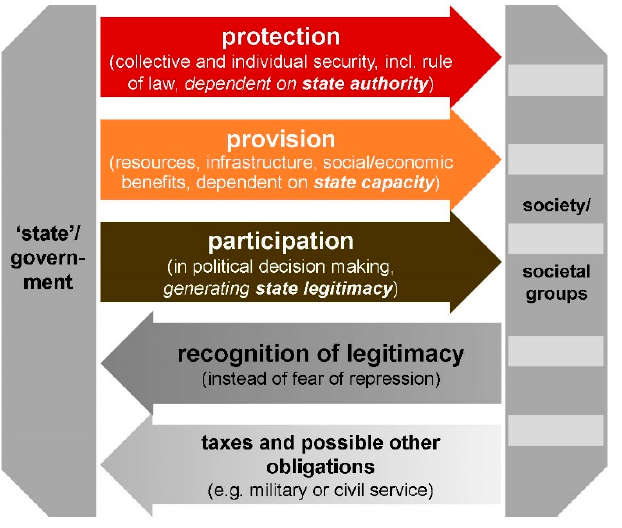
Figure 1. Deliverables in a social contract. Source: Loewe et al. (2019). Available online: https://www.die-gdi.de/briefing-paper/article/the-social-contract-an-analytical-tool-for-countries- in-the-middle-east-and-north-africa-mena-and-beyond/ (accessed on 11 November 2021).